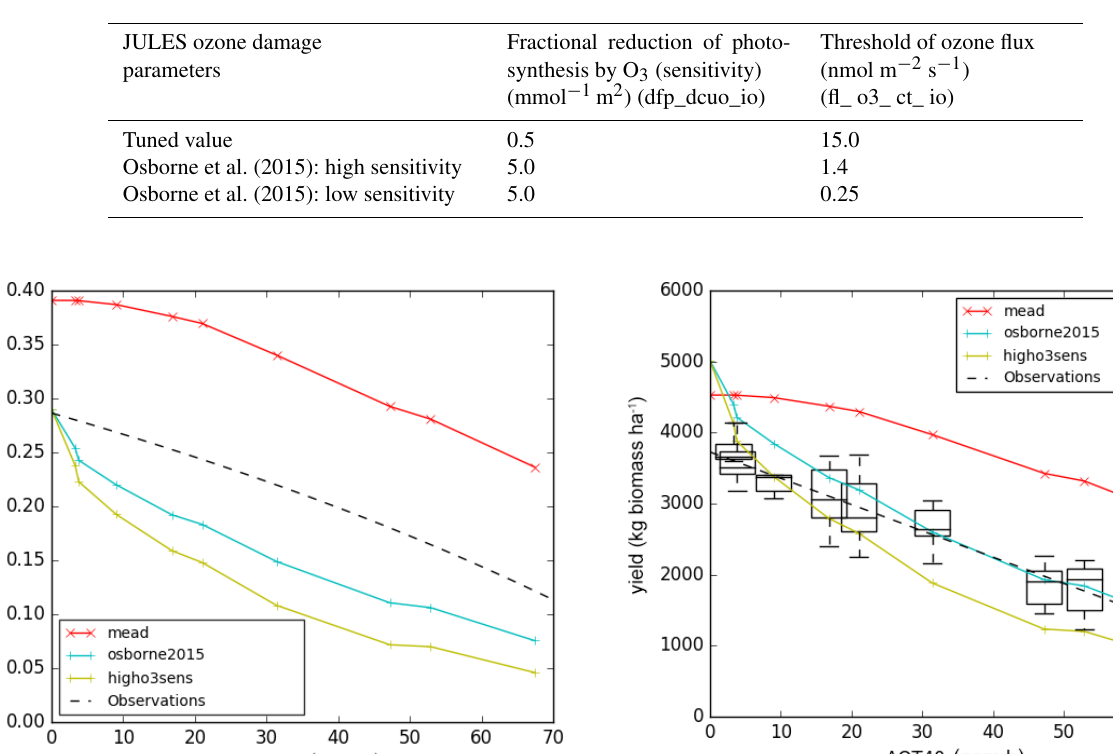
Table 4. Summary of ozone parameter configurations employed in JULES-crop for the default Osborne et al. (2015) value and the tuned as calibrated to SoyFACE leaf gas-exchange measurements (note that these have been calibrated to daytime 8h concentrations and therefore will be different to parameters calibrated to monthly 24h means).